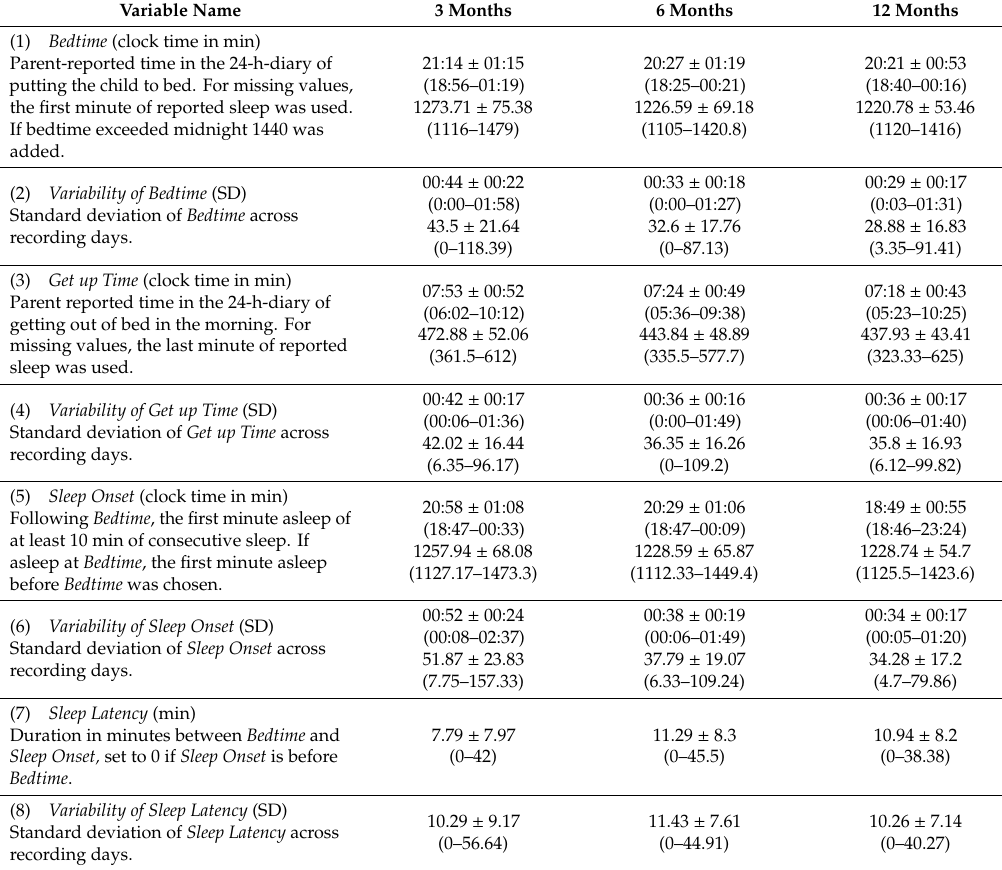
Table 1. Definition and descriptive statistics at 3, 6, and 12 months of the 48 infant sleep variables based on the 24-h-diary and actigraphy that entered the principal component analysis. Bedtime and Get up Time and their variability variables are based on parent report in their 24-h-diary, all other variables are based on actigraphy (with adjustments from diaries as reported in Section 2.4.1). Clock-time variables are reported in two formats: clock times and minutes per day. Mean ± Standard Deviation (Minimum –